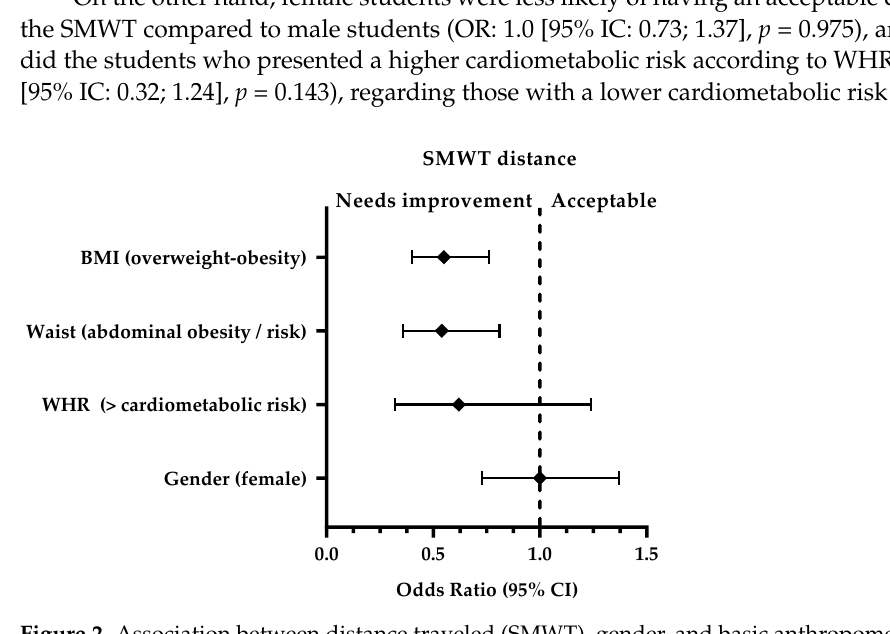
Figure 2. Association between distance traveled (SMWT), gender, and basic anthropometry. Finally, the students who had an acceptable distance traveled in the SMWT where 186% were more likely to have a high or very high V ̇ O 2 max (m·kg·min −1 ), compared to the distance traveled classified as “needs improvement” (OR: 2.86 [95% IC: 2.01; 4.11], p < 0.001) (Figure 1).